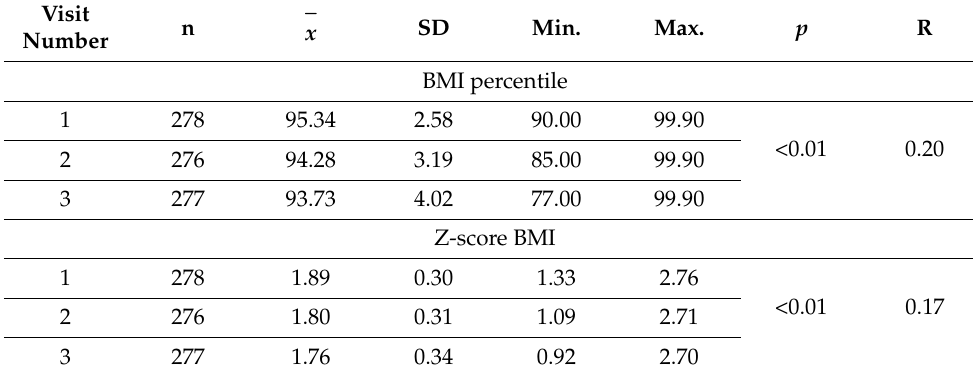
Table 5. Anthropometric parameters of children in the third